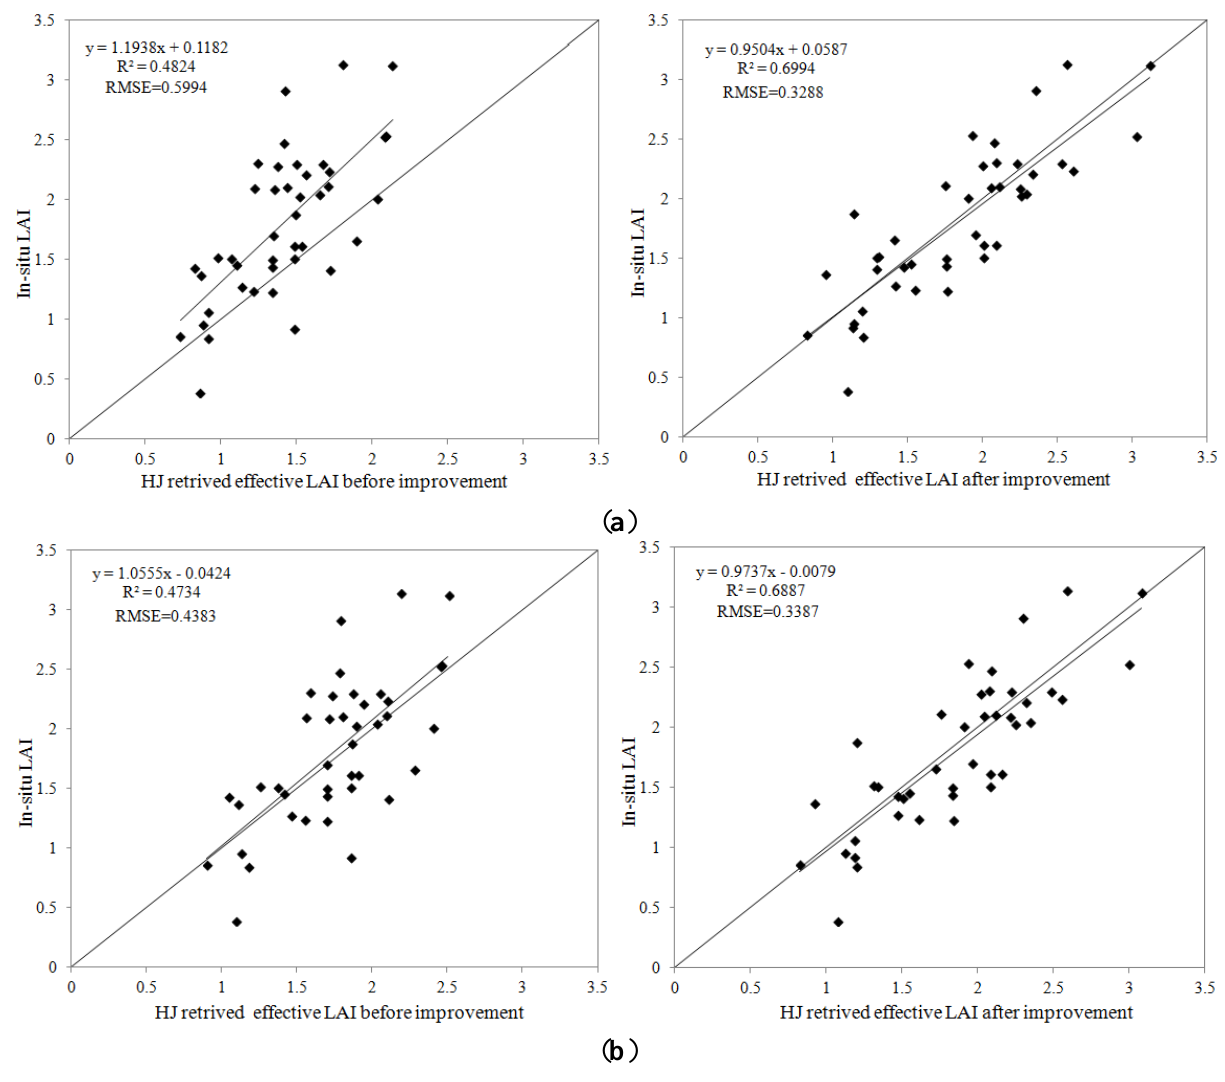
Figure 5. Validation of the HJ-retrieved effective LAI maps before ( left panel ) and after ( right panel ) improvement. ( a ) Validation of the HJ-retrieved effective LAI maps before and after improvement using the LAI-NDVI model. ( b ) Validation of the HJ-retrieved effective LAI maps before and after improvement using the LAI-SR